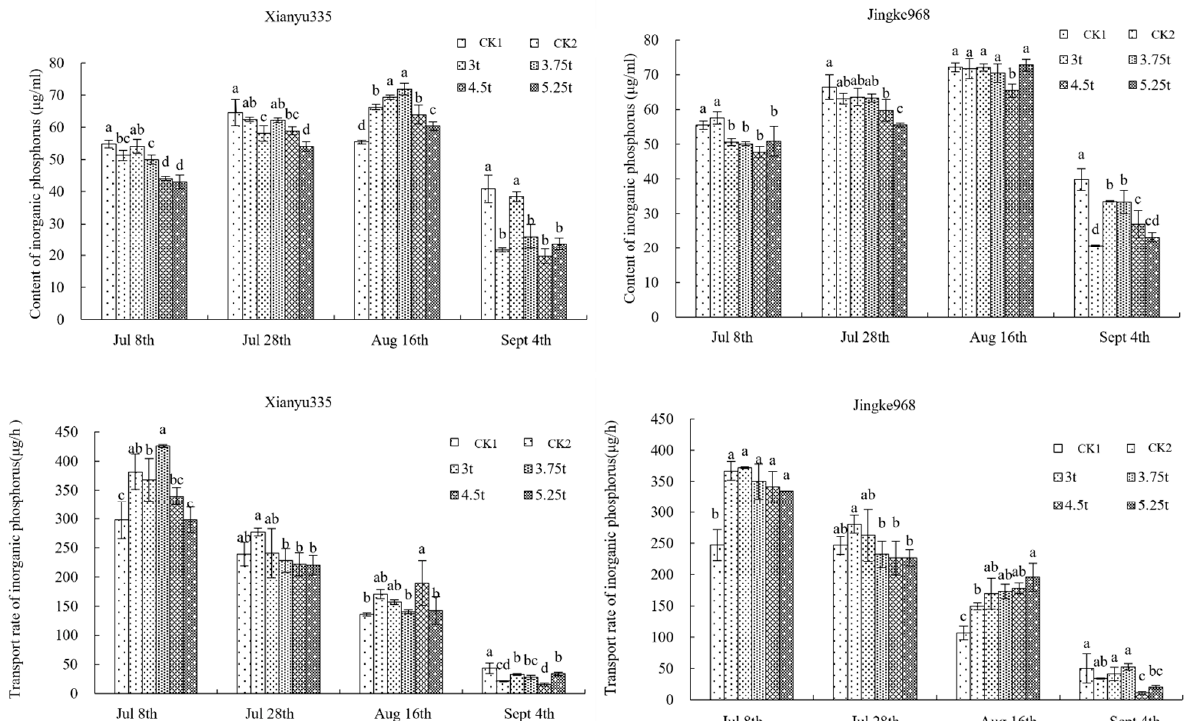
Figure 6. Effects of the carbon-based fertilizer on the content of the inorganic phosphorus and the transport rate of the inorganic phosphorus in maize root bleeding. Notes: data are expressed as mean ± standard deviation. Different letters within the same column indicate a significant difference at the 5% level.